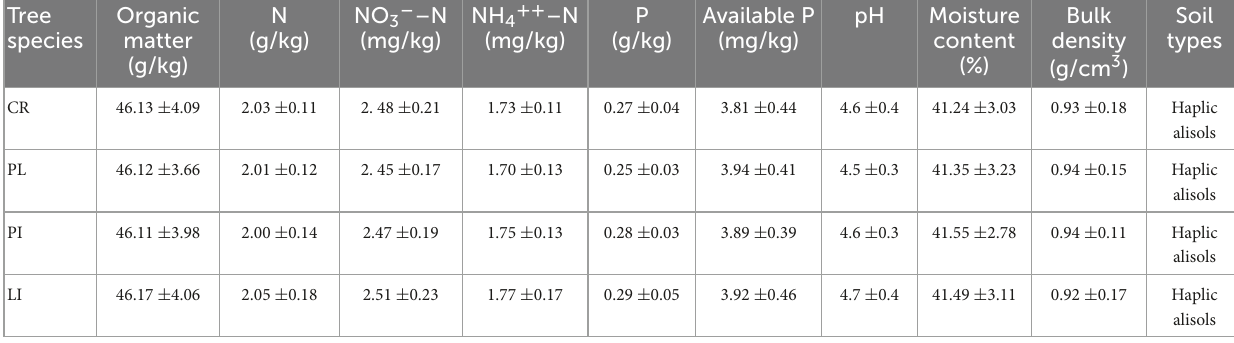
TABLE A1 Means of the initial soil physical and chemical characteristics (0–5 cm depth) in the broadleaved mixed (BLF) subtropical forest in Lu Mountain; values are means ± SEs for n = 6. Tree species